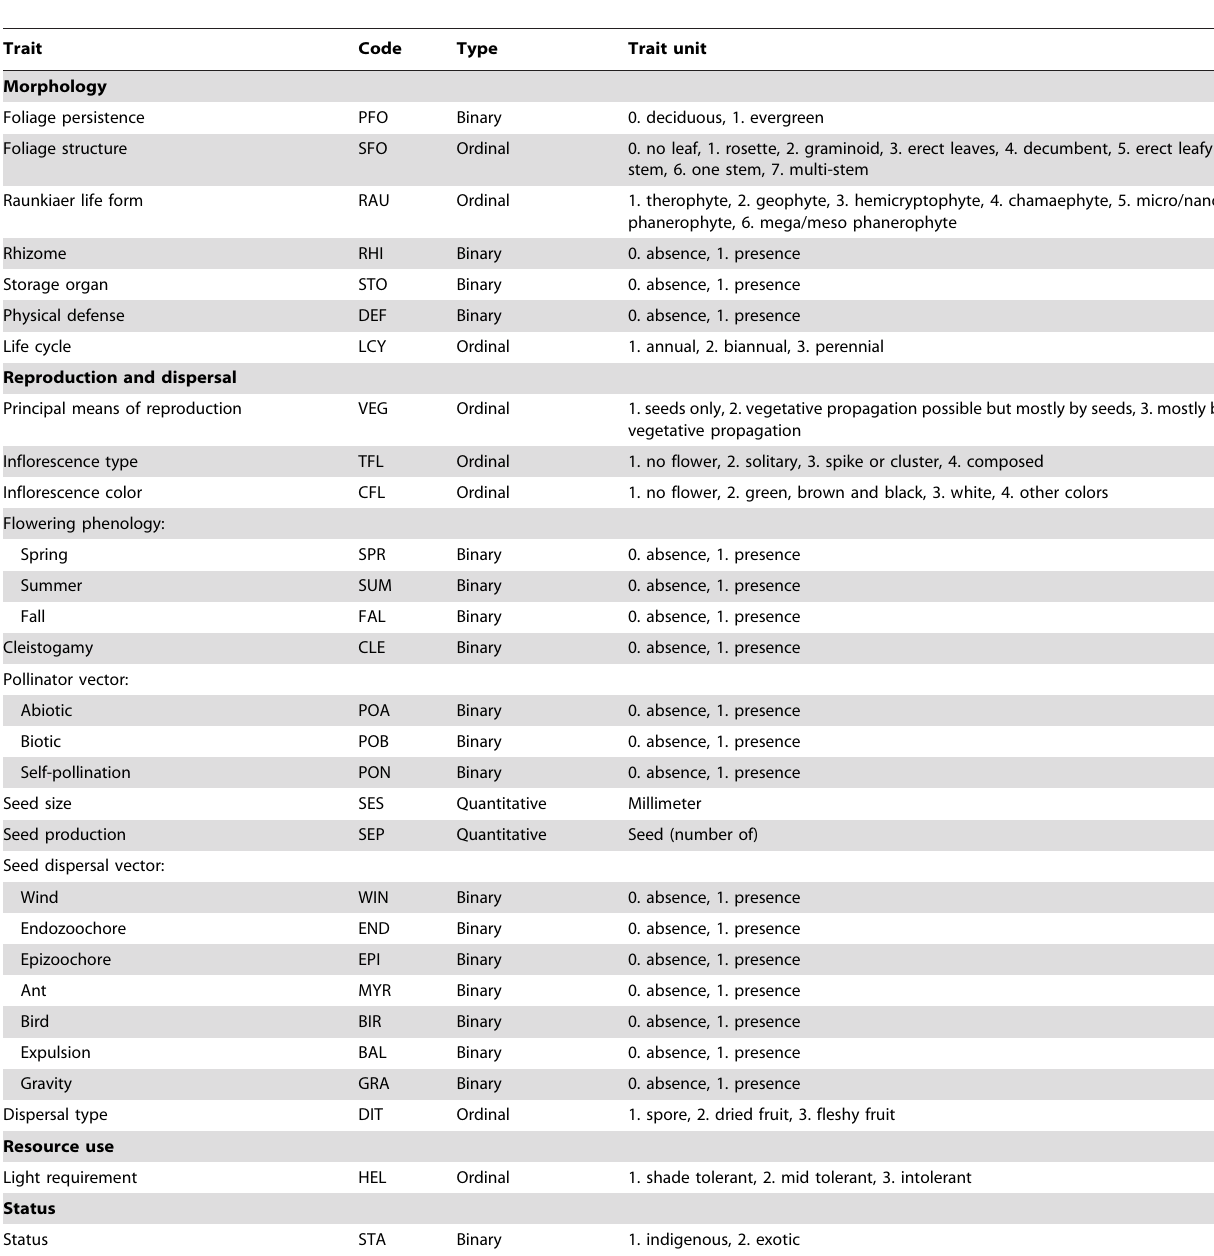
Table 1. Description and codes of the plant functional traits used in this study.